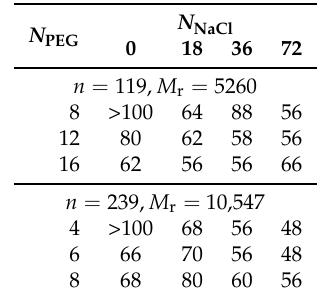
Table 7. Production times (ps) at which the total mass transfer through the plane at z = 20 nm exceeded 2000 Da for different field intensities, E . Systems with eight 5.26-kDa chains were used. E (V/nm)